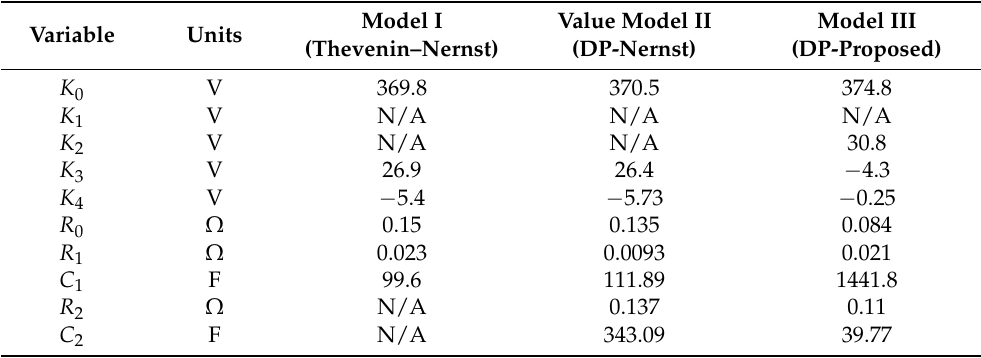
Figure 11. Simulation results following parameter identification using experimental NEDC data: ( a ) experimental and simulated voltage during NEDC identification, Model I; ( b ) experimental and simulated voltage during NEDC identification, Model II; ( c ) experimental and simulated voltage